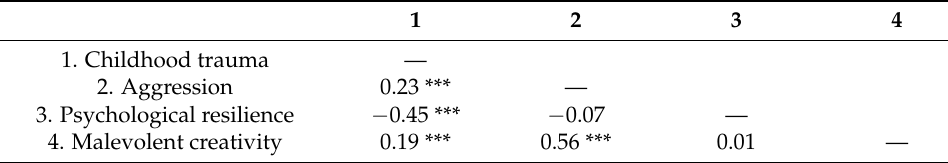
Table 2. Correlation analysis results of study variables.